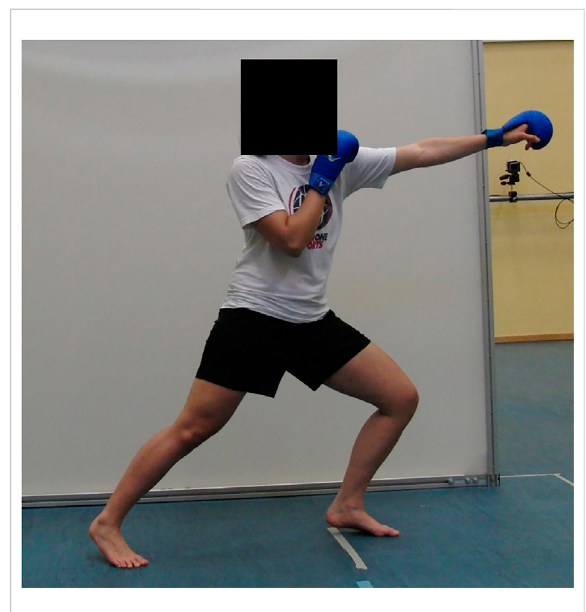
FIGURE 2 Picture demonstrating the fi nal position of the karate attack Kizami Zuki jodan (KZ). Note the difference to GZj (Figure 1)/(4): pushing off the front fi st to the head of the opponent. Starting position and distance reduction towards the opponent are the same as for GZj in Figure